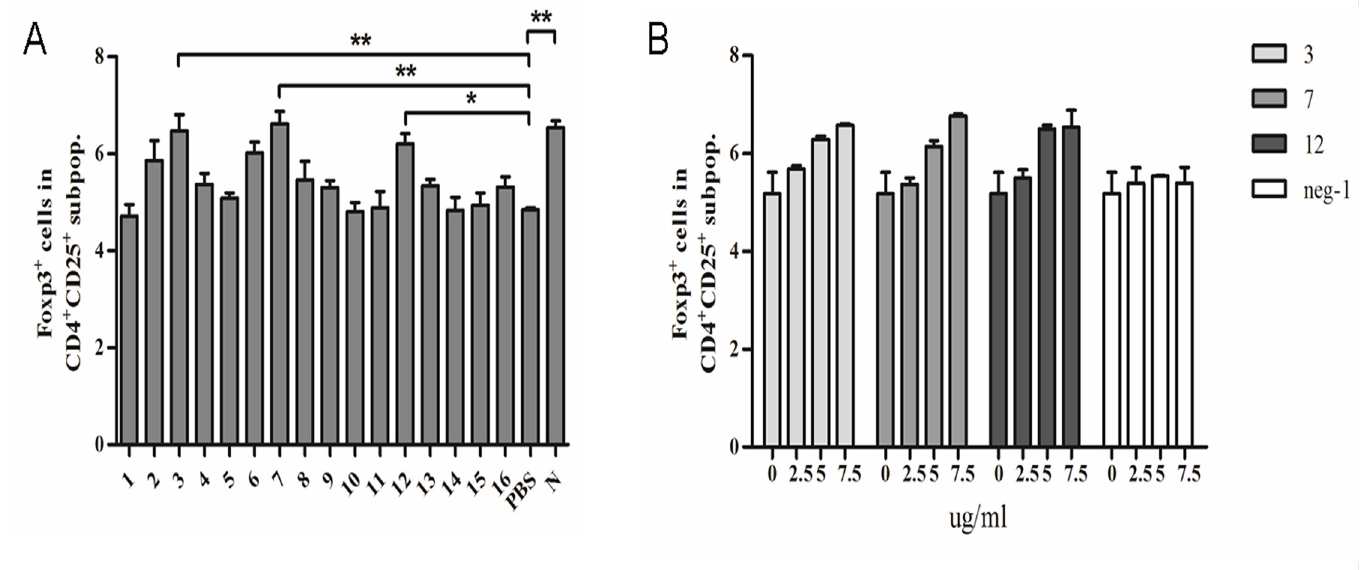
Fig 5. Effects on Tregs induction of synthetic peptides of N protein of HP-PRRSV. (A) Percentage of Foxp3 + cells in the gated CD4 + CD25 + subpopulations of 16 synthetic peptides, which covered the whole length of HP-PRRSV N protein. (B) The dose-dependent manner of three peptides 3, 7 and 12. Data came from three independent experiments. Data analysis was done using one-way ANOVA and significant differences are shown ( * P < 0.05 and ** P < 0.01).